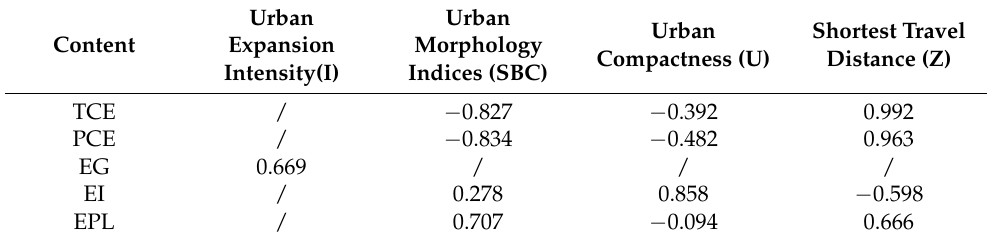
Table 7. Relational grades between carbon emission indices and the urban sprawl index.